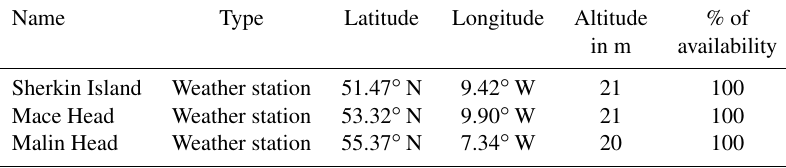
Table 2. Location and characteristics of the coastal weather stations used in the comparison with Sentinel-1 SAR Level 2 OCN